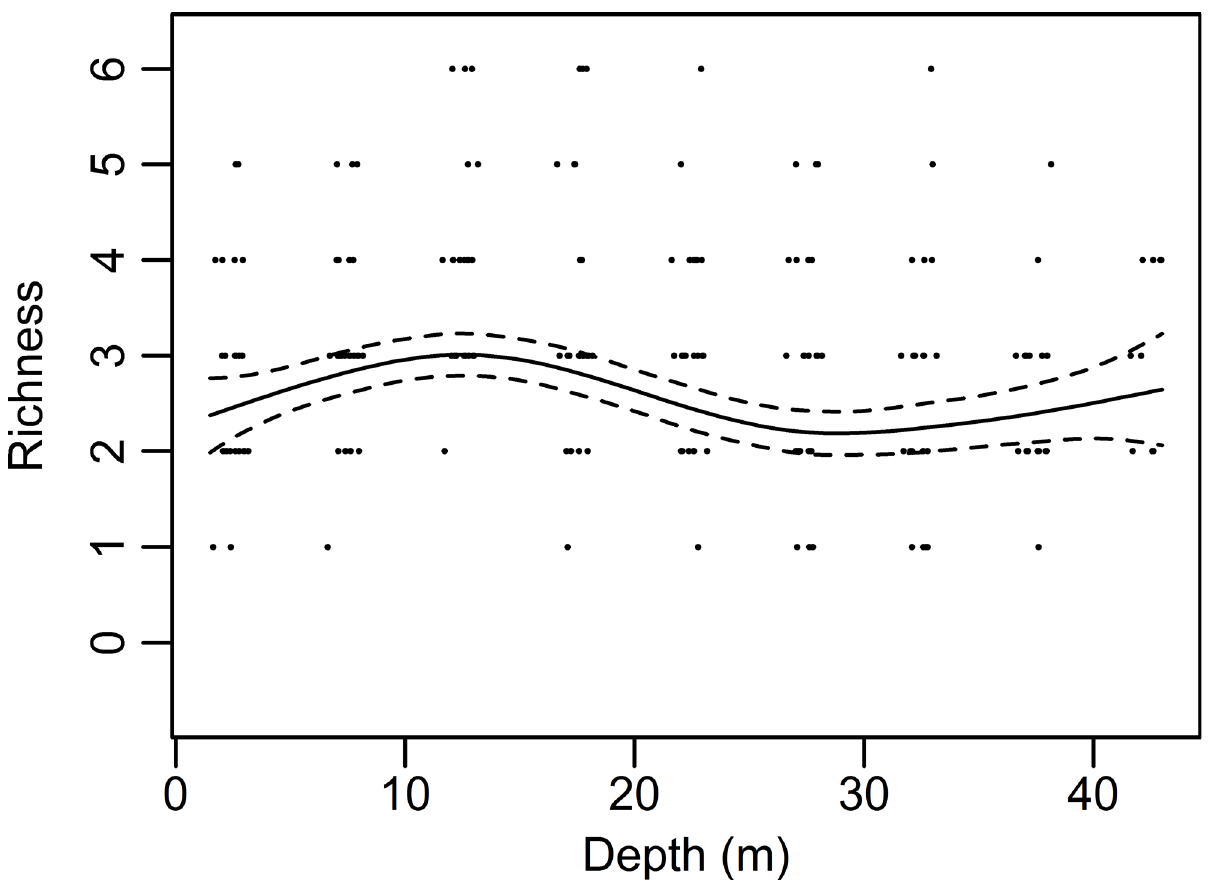
Fig 3. Modelled relation of species richness (S) with depth. Plot of the fitted Generalised Additive Model smoother showing the significant non-linear effect of depth (p = 0.001) on the species richness (S) on all platforms.